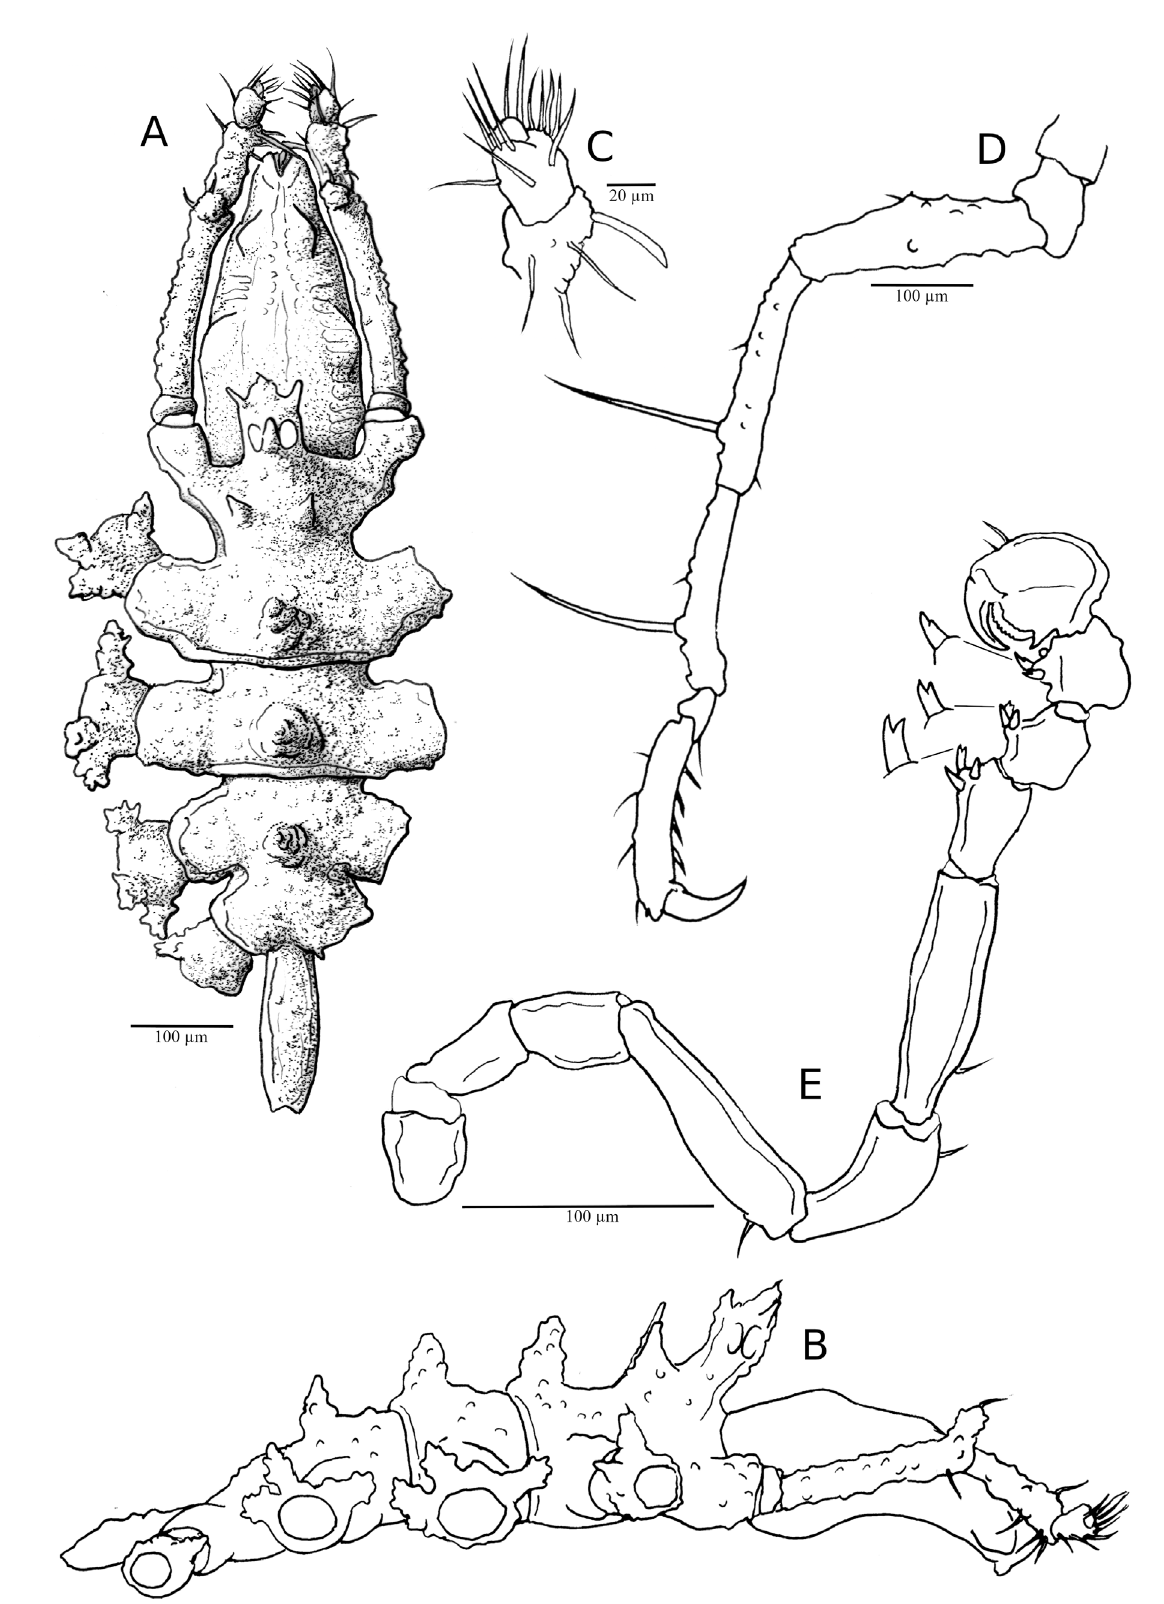
Fig. 31. Rhynchothorax sidereus sp. nov., holotype, MNHN-IU-2016-817. A . Body, dorsal view. B . Body, lateral view (same scale as A). C . Palp terminal segments, ventral view. D . Third leg. E .